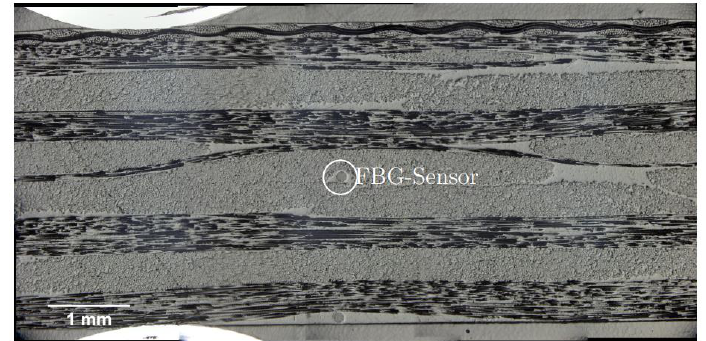
Figure 9. Cross-section of the GFRP laminate for evaluation of the local FBG sensor position.